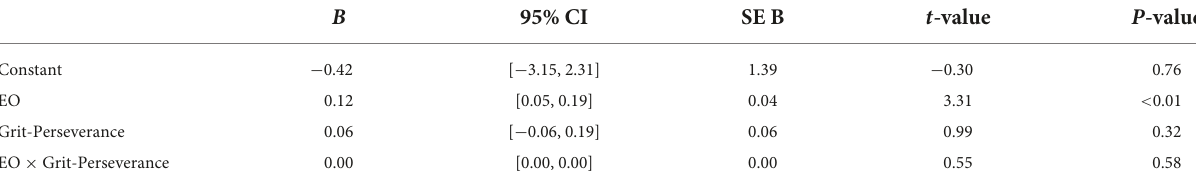
TABLE 3 Linear model of predictors of PSB, considering Grit-Perseverance ( R 2 = 28.08%, p < 0.001). B 95% CI SE B t -value